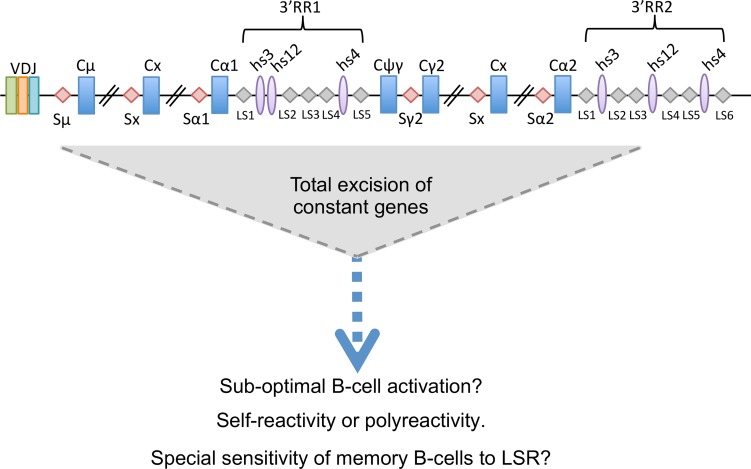
Model of LSR in the human IgH locus.Recombination between Sμ and LS regions in the 3’RR2 super-enhancer results in complete deletion of constant regions of all immunoglobulin classes leading to absence of BCR membrane expression. LSR could be a physiological mechanism to eliminate sub-optimally activated B-cells or those that are poly or autoreactive. Resting memory B-cells seem especially sensitive, as they do not carry stigmas of LSR, which only occurs in activated B-cells.